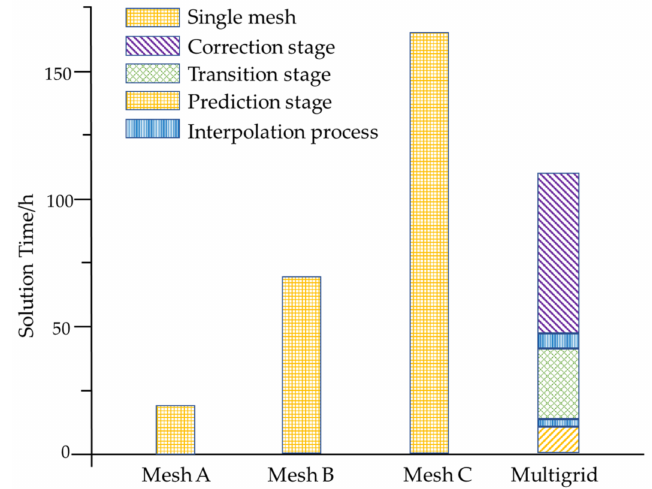
Figure 12. Comparison of the computation time by a single set of mesh and multigrid.